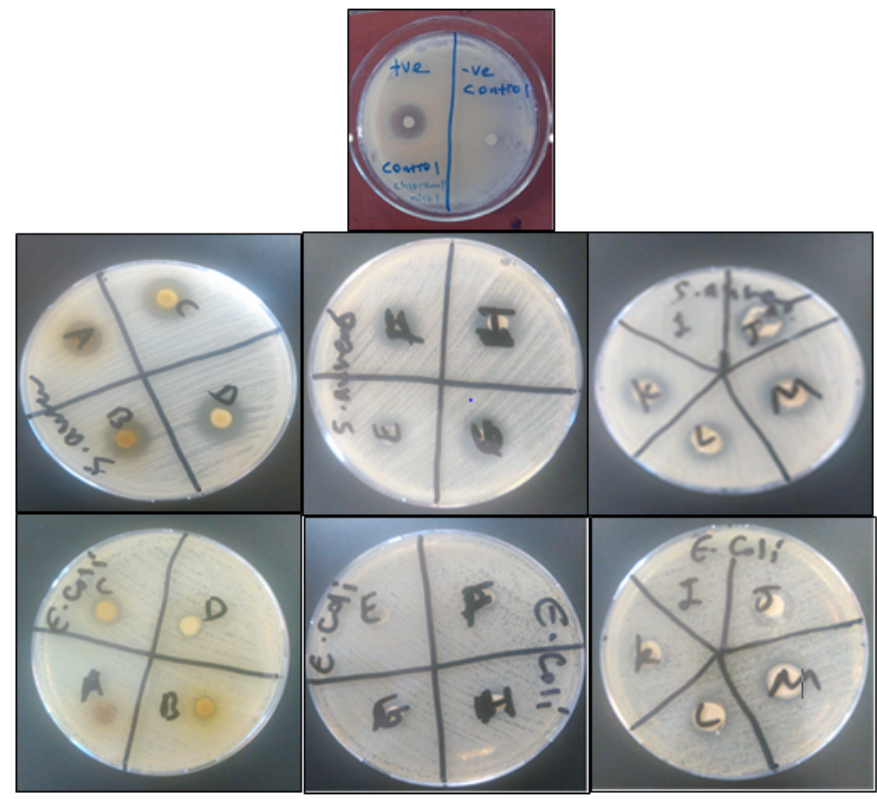
Figure 17: Measured Inhibition zones of S.aureus and E.coli with free PVA, ZnO NPs and ZnO/PVA